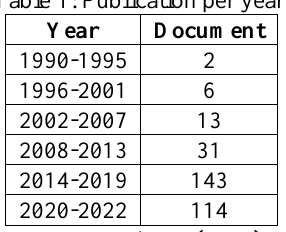
Table 3: Document by Country or